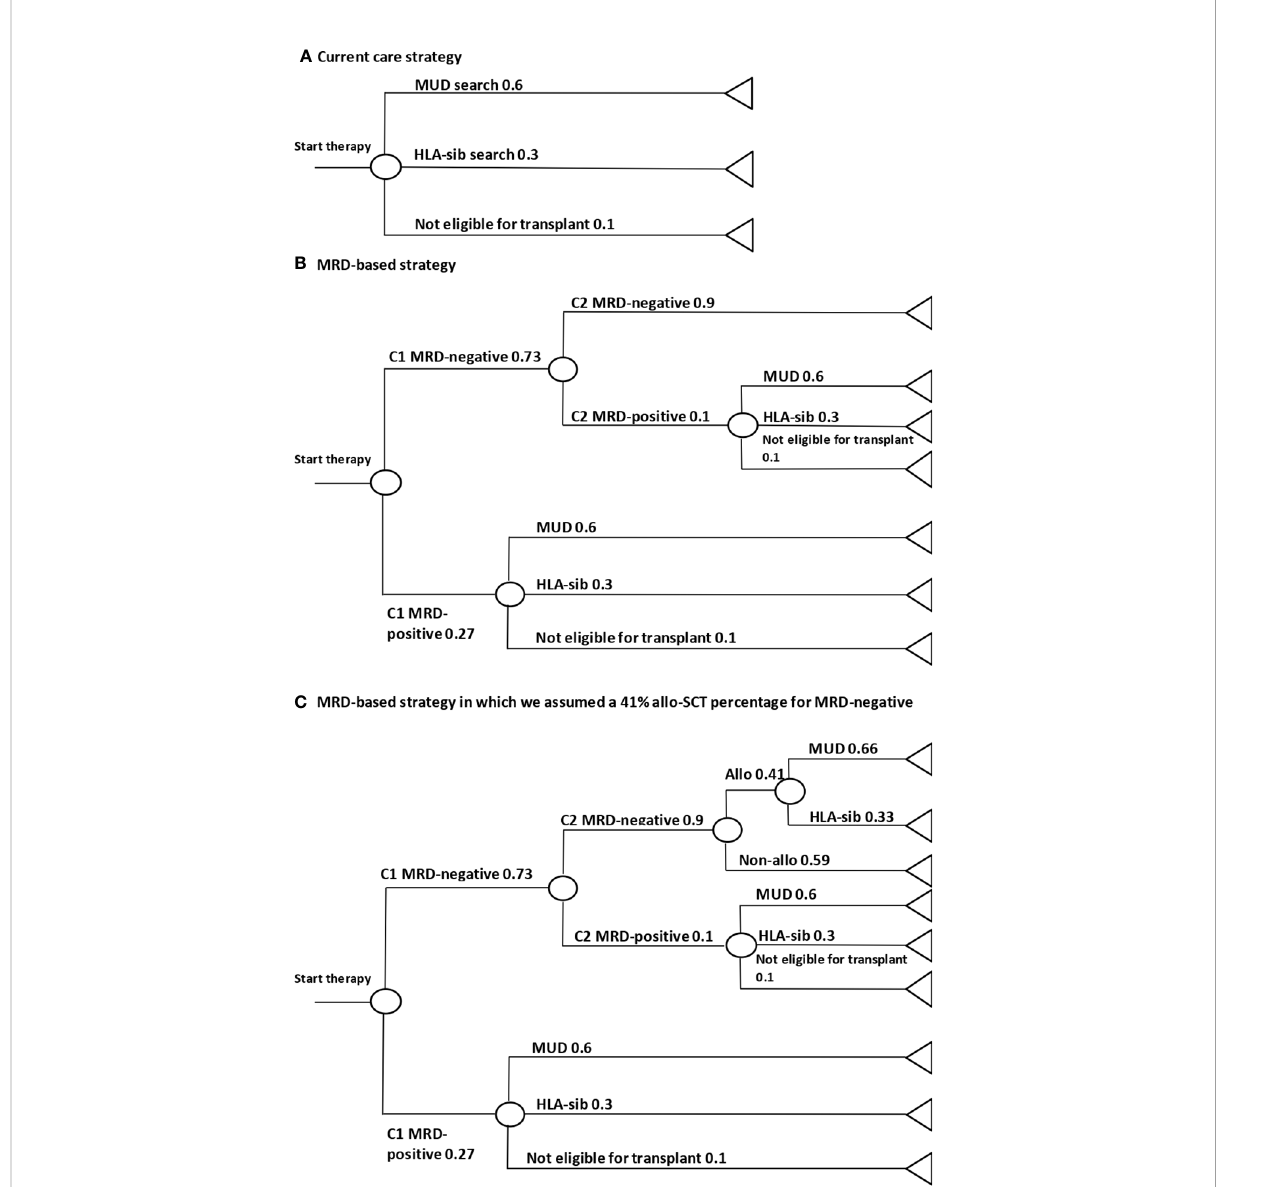
FIGURE 1 Decision trees of the three different strategies. (A) Current care strategy for intermediate risk patients were a donor is search is initiated for about 90% of patients of which 60% are match unrelated donors (MUD) and 30% siblings with HLA-match (HLA-sib). (B) MRD-based strategy were MRD-negative patients do not receive an allogeneic stem cell transplantation (allo-SCT). (C) Combination of MRD-based strategy with addition of treating physicians discretion, in which 41% of the MRD-negative patients after cycle 2 still receive an allo-SCT. This is the same allo- SCT percentage for MRD-negative patients as in this